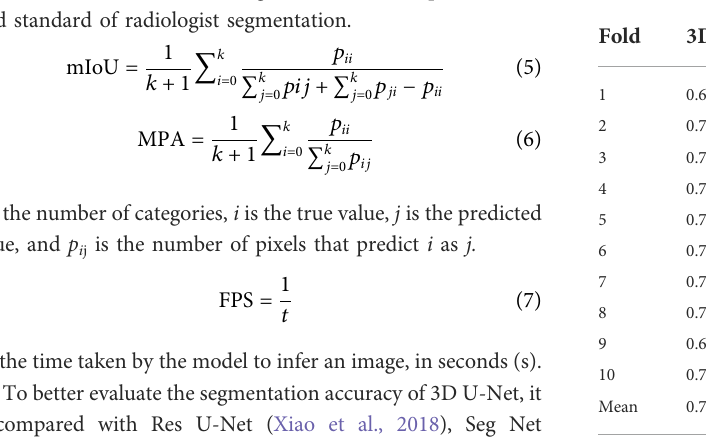
TABLE 4 DSC of the four methods on the training